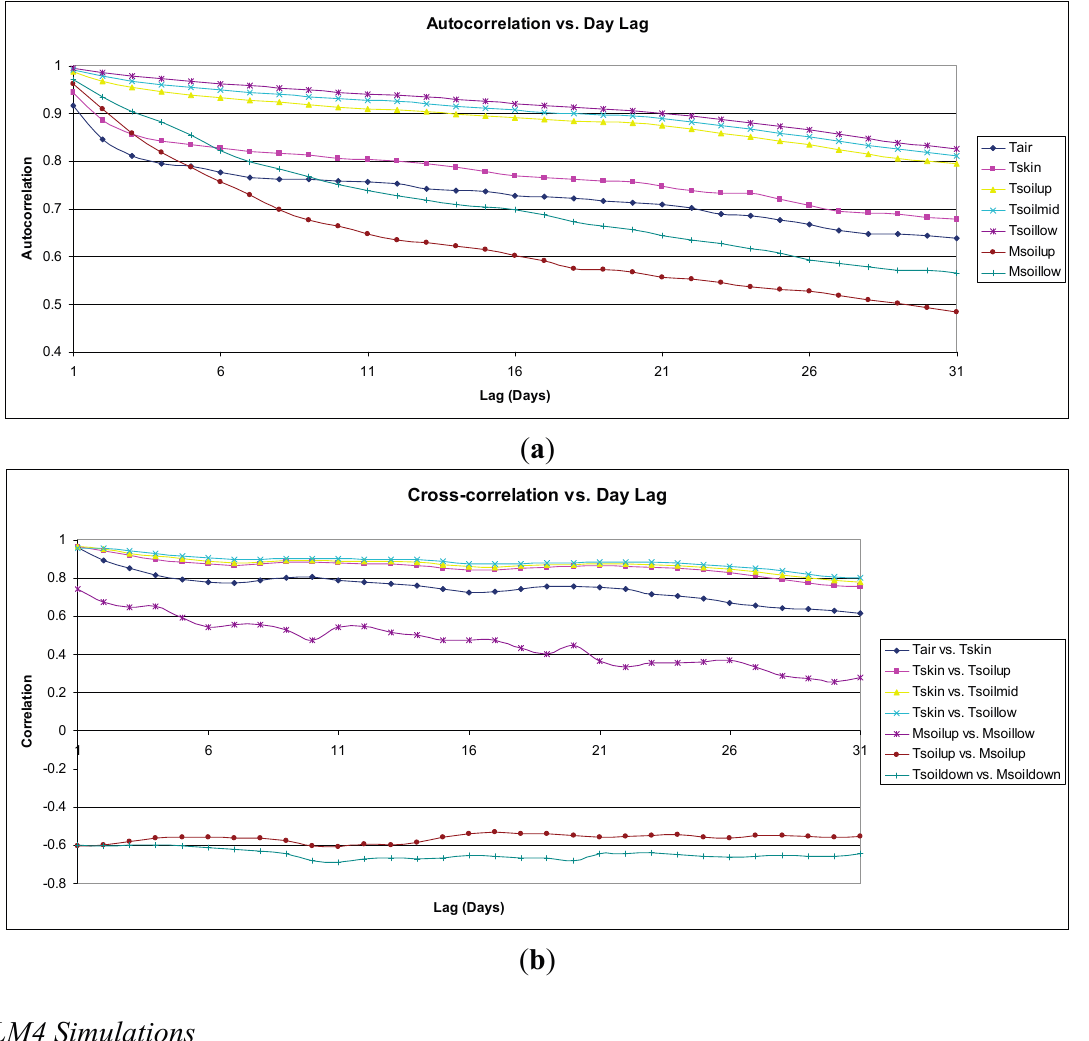
Figure 5. ( a ) Autocorrelation with day lag using daily averaged data from 2003–2008 data. T is 2-m air temperature. T air is middle layer soil temperature. T are upper and low soil moisture, respectively. ( b ) Cross-correlation with day